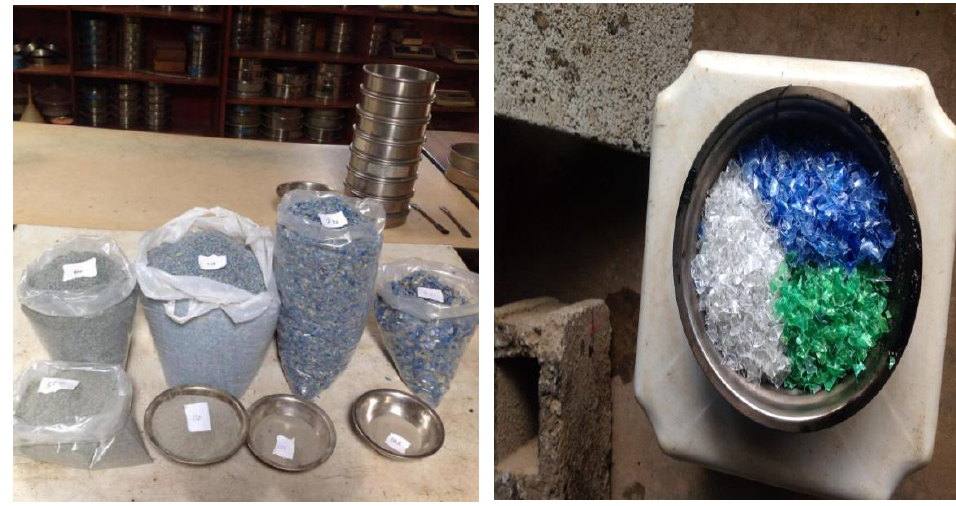
Figure 1. Coarse and fine PET particles. Table 2. Physical properties of waste PET